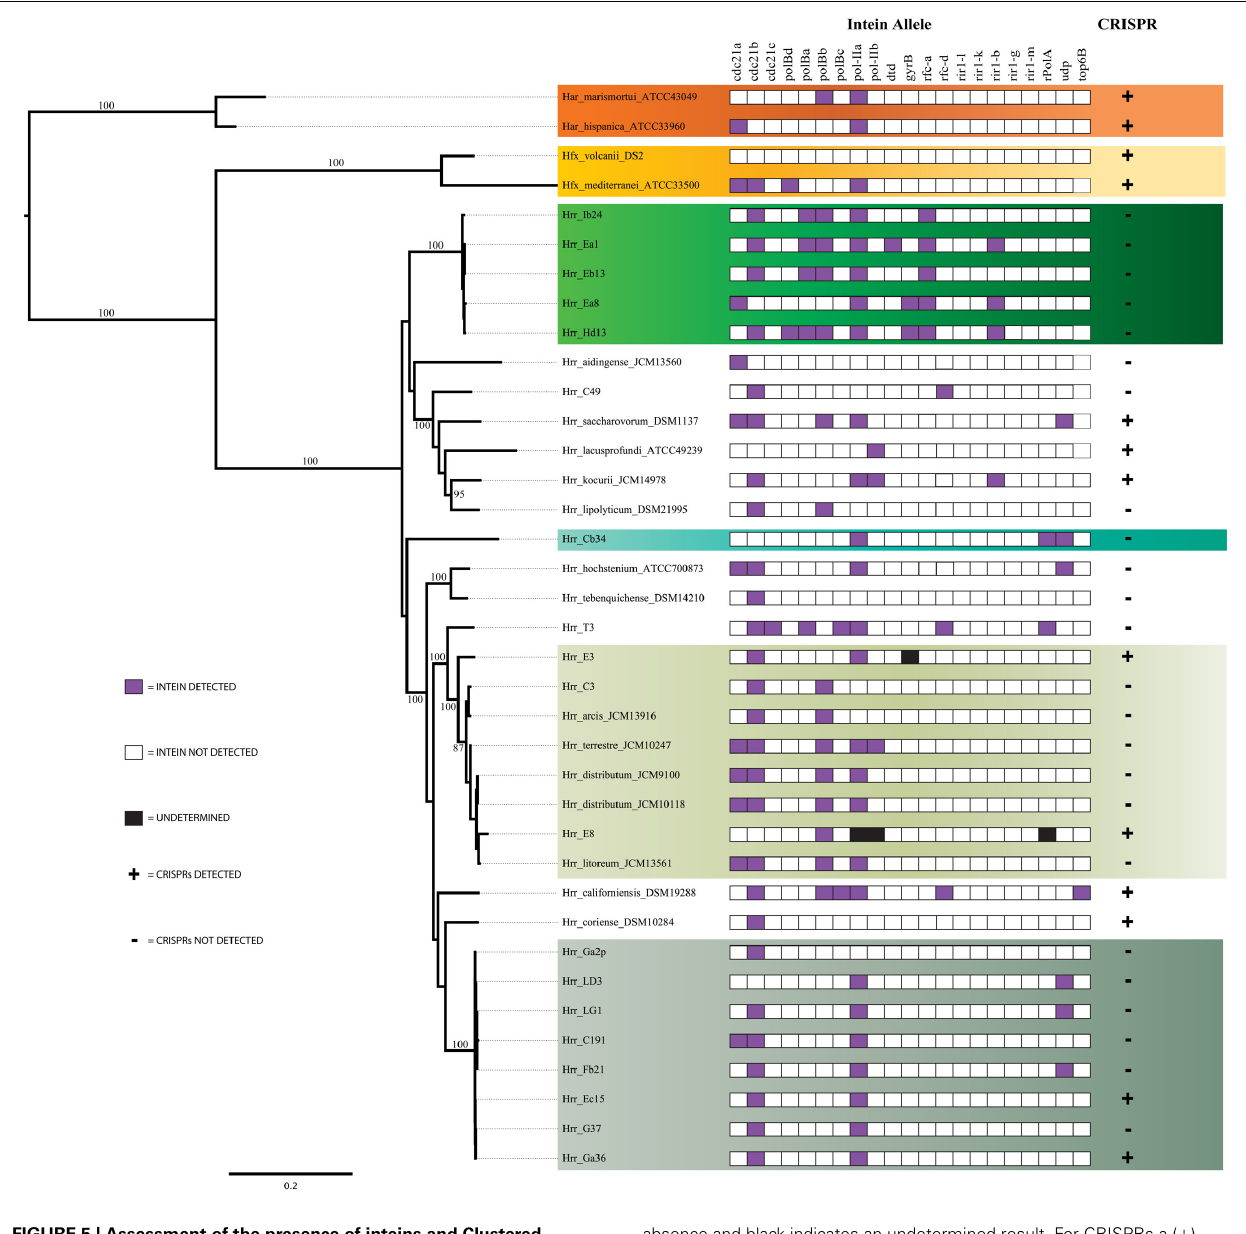
absence and black indicates an undetermined result. For CRISPRs a ( + ) indicates the presence of one or more CRISPRs and a (–) indicates the absence of